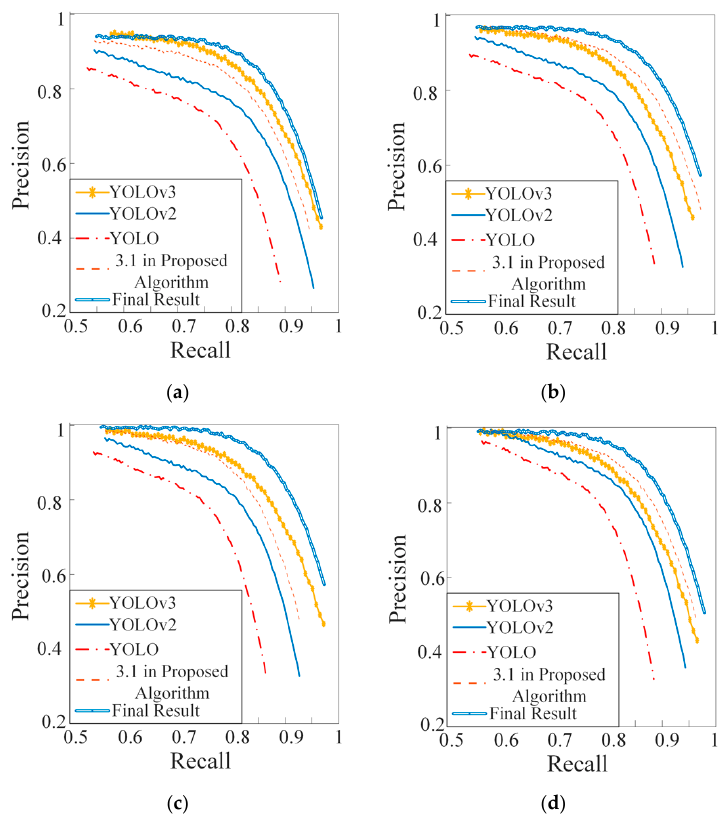
Figure 8. Precision-Recall Curve (PRC). “3.1 in Proposed Algorithm” represents the improvement of YOLOv2 only through “Image rotation algorithm based on SHT”; "Final Result" represents the result corresponding to the complete algorithm proposed in this paper. ( a ) Iteration 5000, ( b ) iteration 10,000, ( c ) iteration 15,000, ( d ) iteration